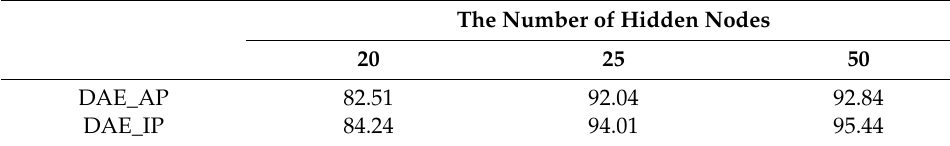
Table 2. The recognition rates (%) of DAE_AP and DAE_IP.